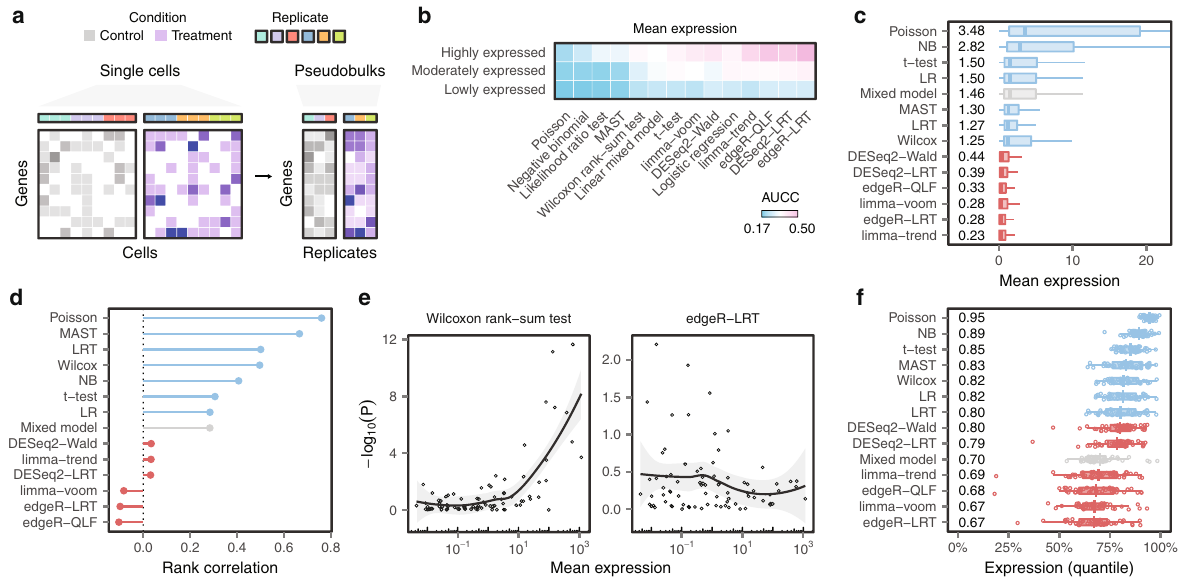
Fig. 2 Single-cell DE methods are biased towards highly expressed genes. a Schematic illustration of the creation of ‘ pseudobulks ’ from single-cell data. Top, biological replicate from which each cell was obtained. Bottom, simulated gene expression matrix. Read counts for each gene are aggregated across cells of a given type within each biological replicate. b Mean AUCCs across eighteen ground-truth datasets after dividing the transcriptome into terciles of lowly, moderately, or highly expressed genes. c Mean expression levels of the 100 top-ranked false-positive genes from each DE method. d Spearman correlation between the mean expression of 80 ERCC spike-ins expressed in at least three cells and the – log 10 p -value of differential expression assigned by each DE method. e Scatterplots of mean ERCC expression vs. – log 10 p -value for exemplary single-cell and pseudobulk DE methods. Trend lines and shaded areas show local polynomial regression and the 95% con fi dence interval, respectively. f Mean expression levels of the 200 top-ranked genes from each DE method in a collection of 46 scRNA-seq